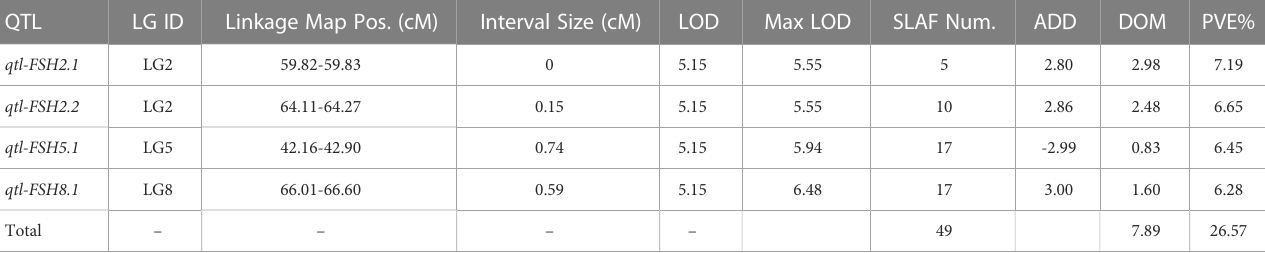
TABLE 3 Analysis of quantitative trait loci (QTL) for fl ower stalk height in onion. QTL LG ID Linkage Map Pos. (cM) Interval Size (cM) LOD Max LOD